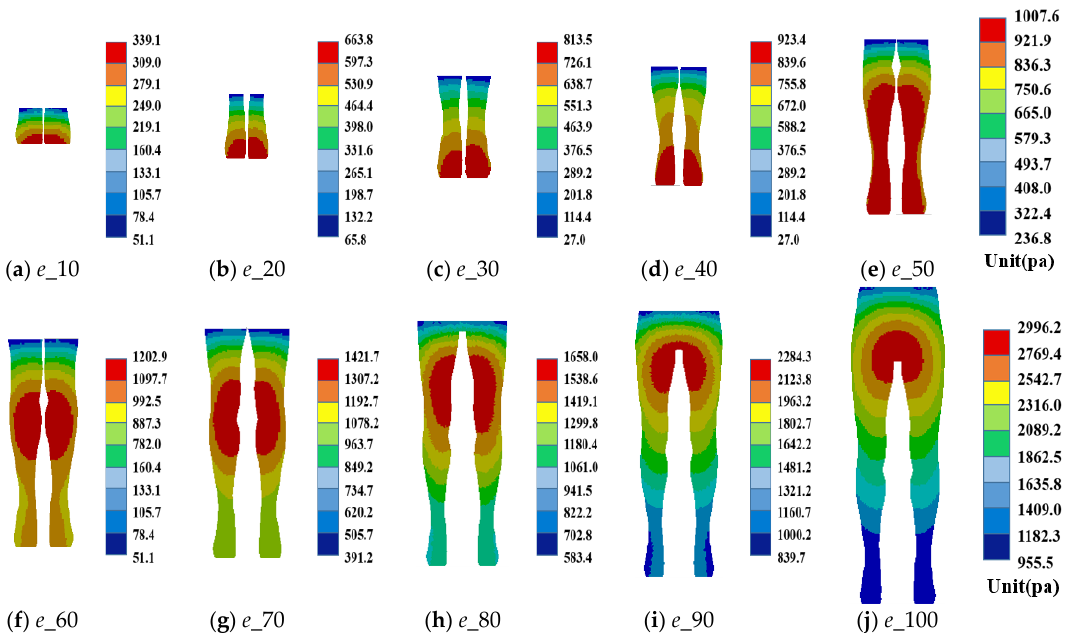
Figure 20. Hydrodynamic pressure of child walking at a minimum safe speed at different flood heights.